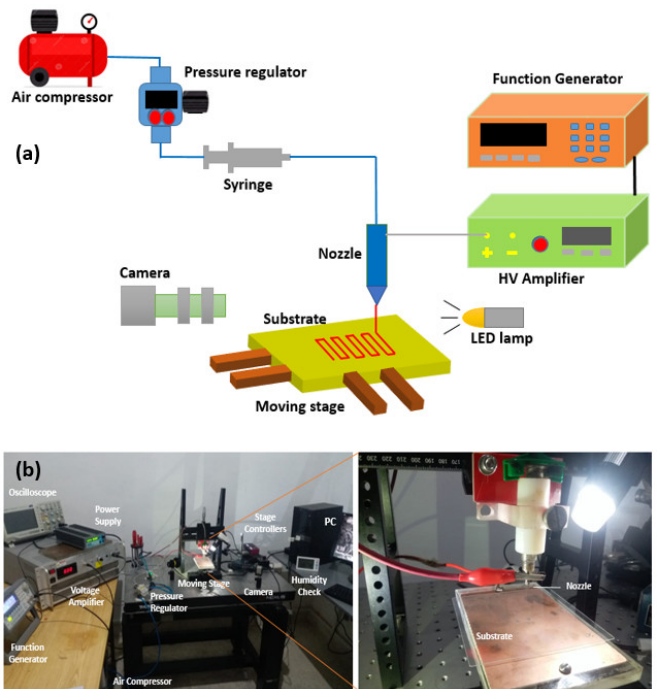
Figure 1. Electrohydrodynamic (EHD) printing experimental setup. ( a ) Schematic illustration. ( b ) Photograph.